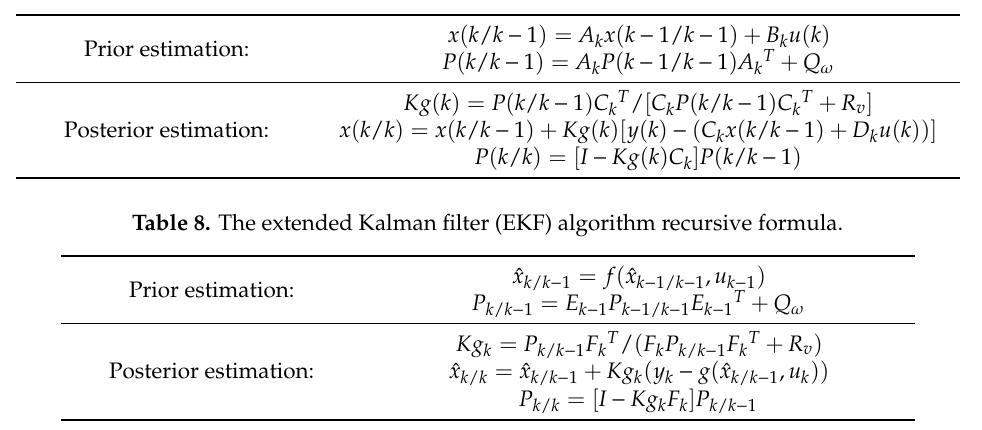
Table 7. The Kalman filter (KF) algorithm recursive formula.